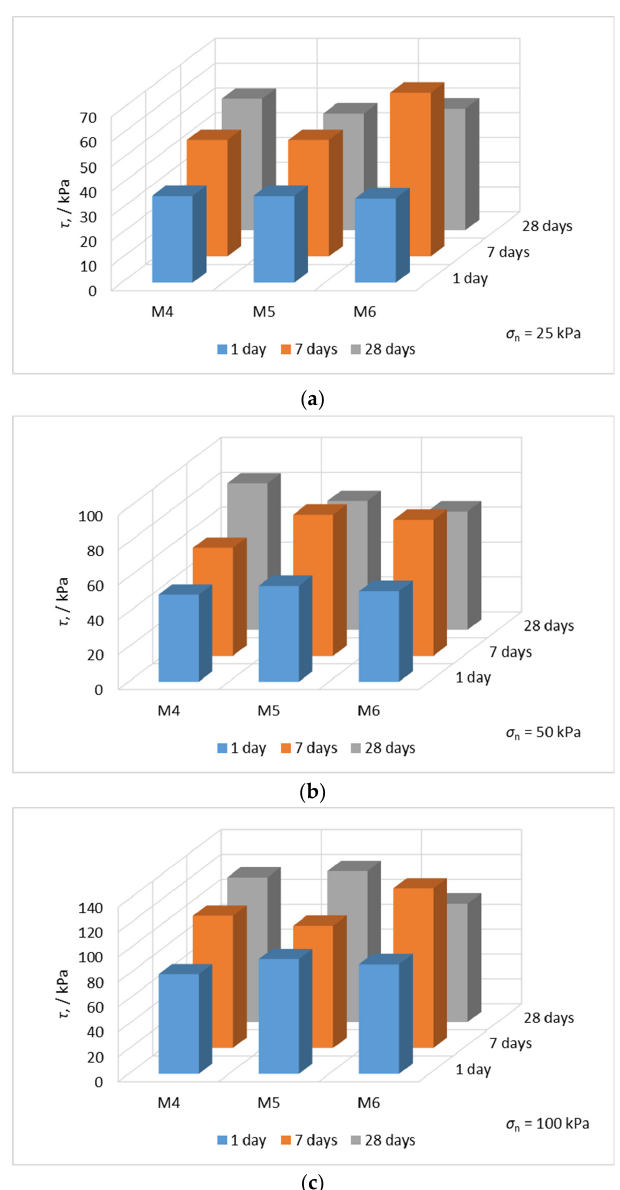
Figure 9. Comparison of peak shear stress values of samples M4–M6 (influence of lime) for samples aged 1 day, 7 days and 28 days: ( a ) σ n = 25 kPa; ( b ) σ n = 50 kPa; ( c ) σ n = 100 kPa.